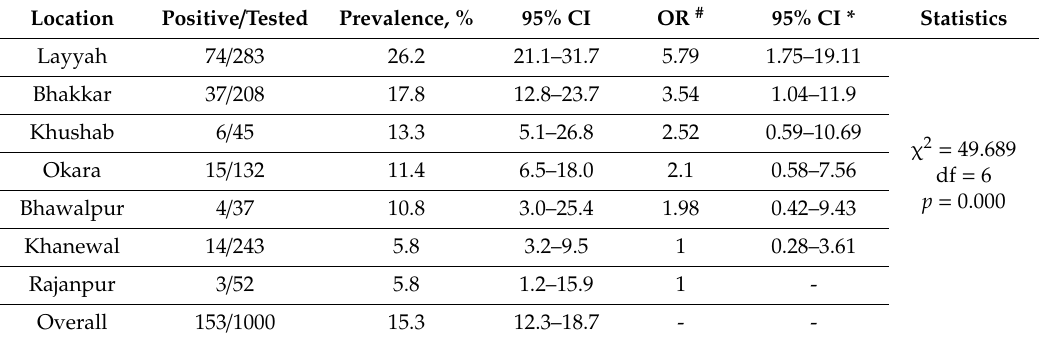
Table 1. Seroprevalence of coxiellosis in small ruminants in seven districts of Punjab,